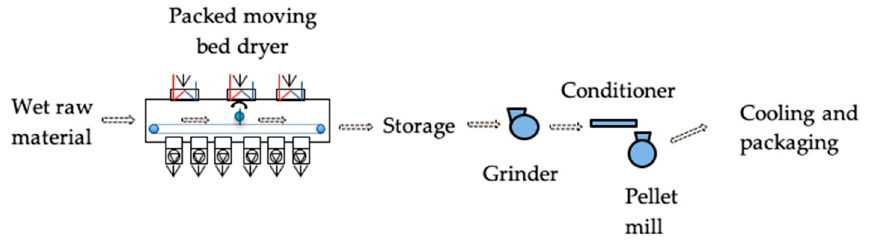
Figure 1. The pellet production chain and setup for using a single packed moving bed (PMB) dryer.